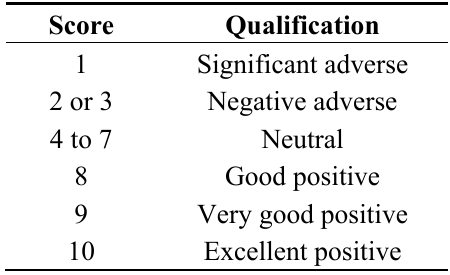
Table 6. Explanation of environmental impact